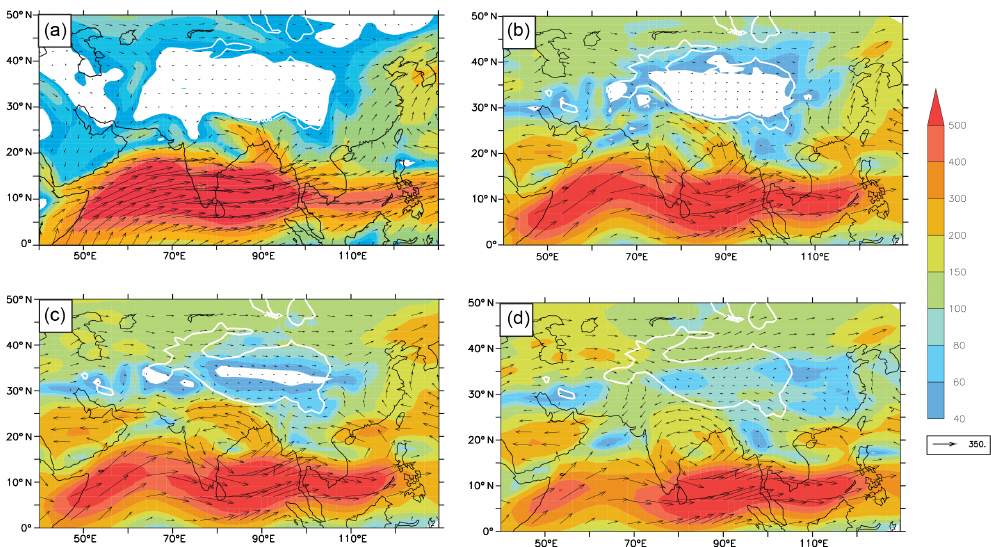
Figure 5. Directions and intensity of JJA vertically integrated humidity transport for: (a) averaged from ERA-40 re-analysis and for (b) MOD case, (c) INT case, (d) LOW case.